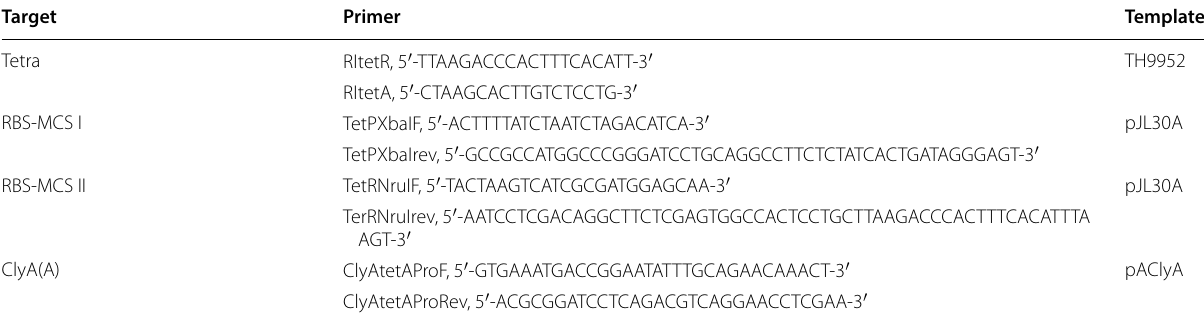
Table 1 Primers used in this study